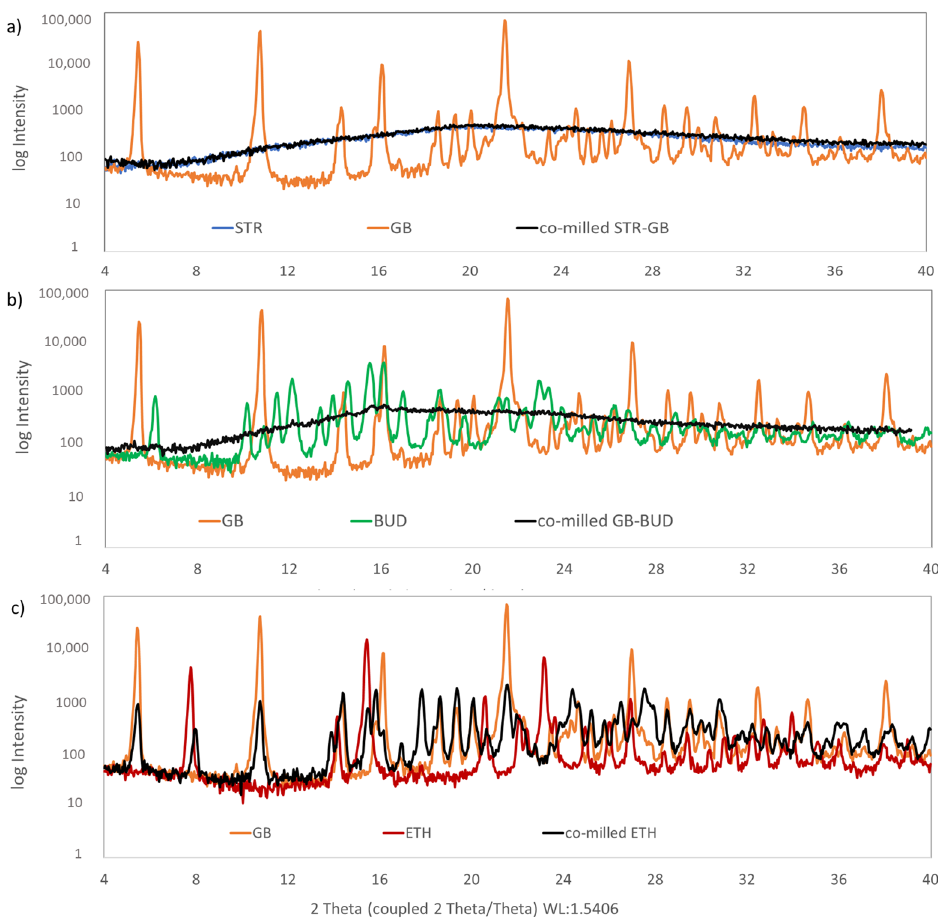
Figure 6. XRPD pattern of starting materials (API 1 and API 2) and co-milled samples of ( a ) streptomycin sulphate (STR) and glycopyrronium bromide (GB), ( b ) glycopyrronium bromide and budesonide (BUD) and ( c ) glycopyrronium bromide and ethambutol (ETH).